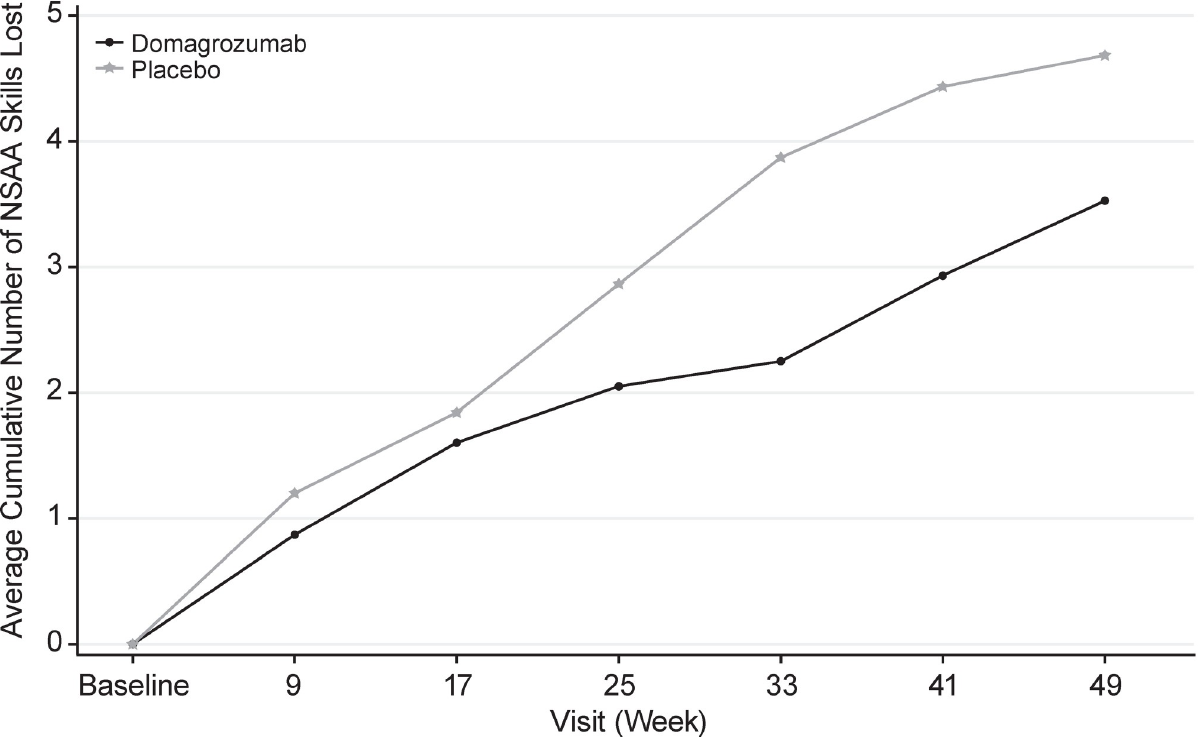
Fig 5. Cumulative loss of individual NSAA skills over 48 weeks (full analysis set). Event was defined as a patient dropping from 2 or 1 (able to perform a task) to 0 (unable to perform). This exploratory analysis included transient zero scores that may have increased to a value above zero at a subsequent visit. NSAA, North Star Ambulatory Assessment.